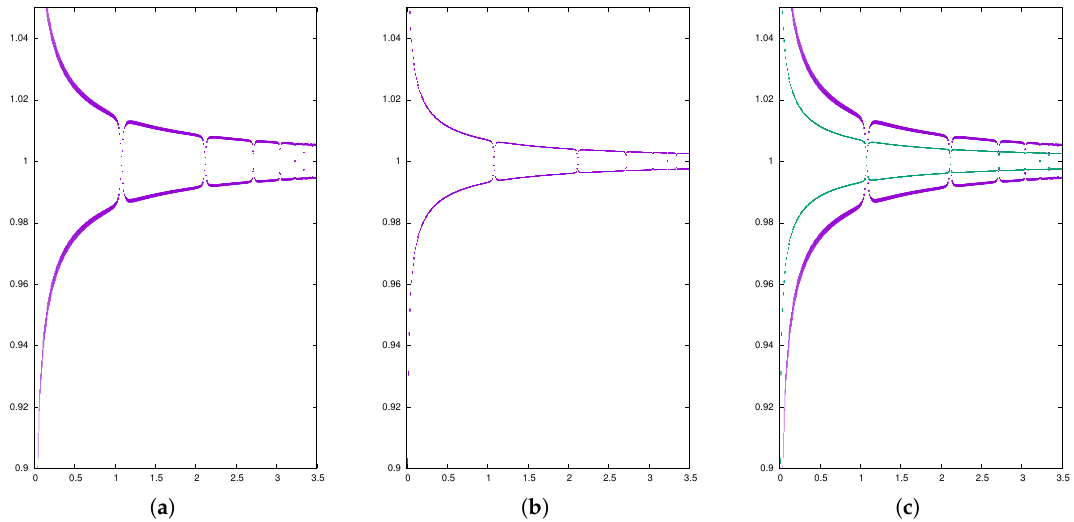
Figure 7. Bifurcation diagrams for β = 0 and initial condition x 0 = 0.3. Horizontal axis is α and vertical axis is x n . ( a ) First 1000 iterations discarded. ( b ) First 5000 iterations discarded. ( c ) Both diagrams ( a ) and ( b